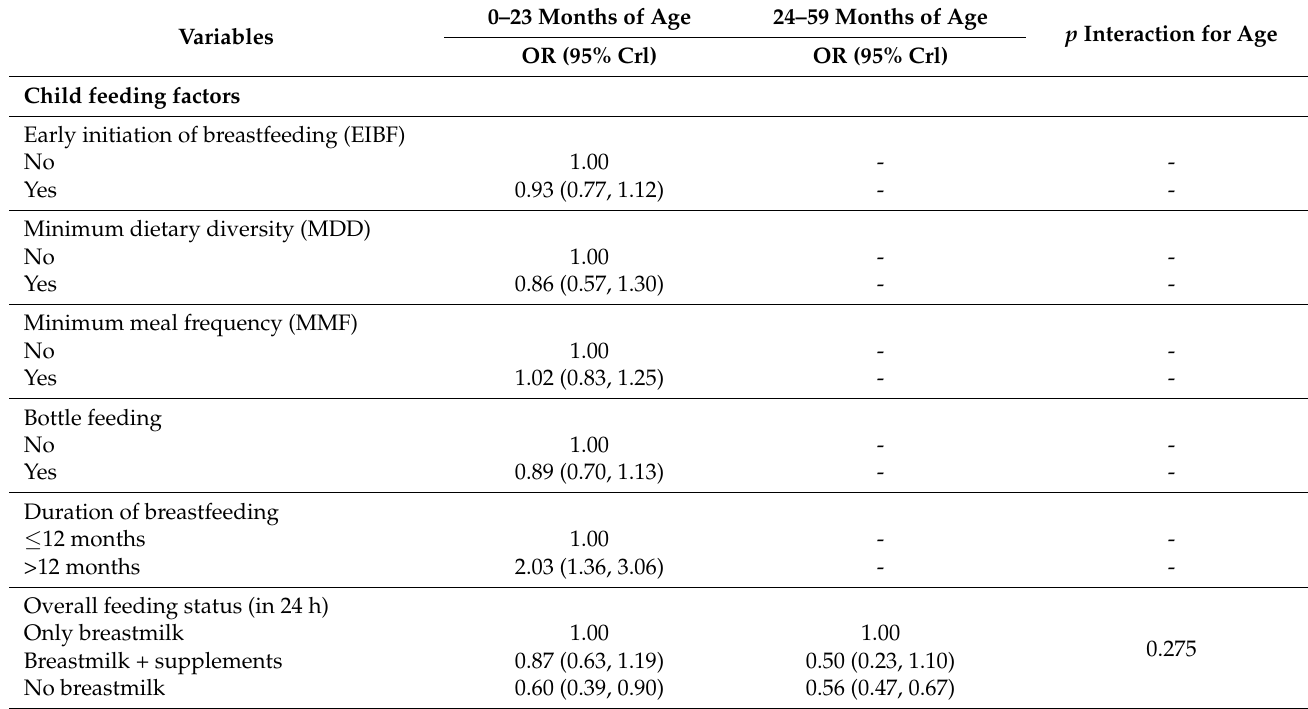
Table 1. Non-spatial modelling for proximal and contextual determinants of stunting among children under five years of age in Ethiopia, 2016 EDHS ( n =